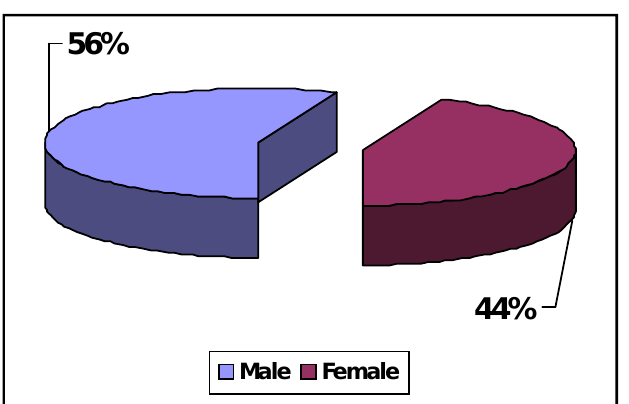
Fig. 11 : JE Deaths: Gender Cummulative, 2002